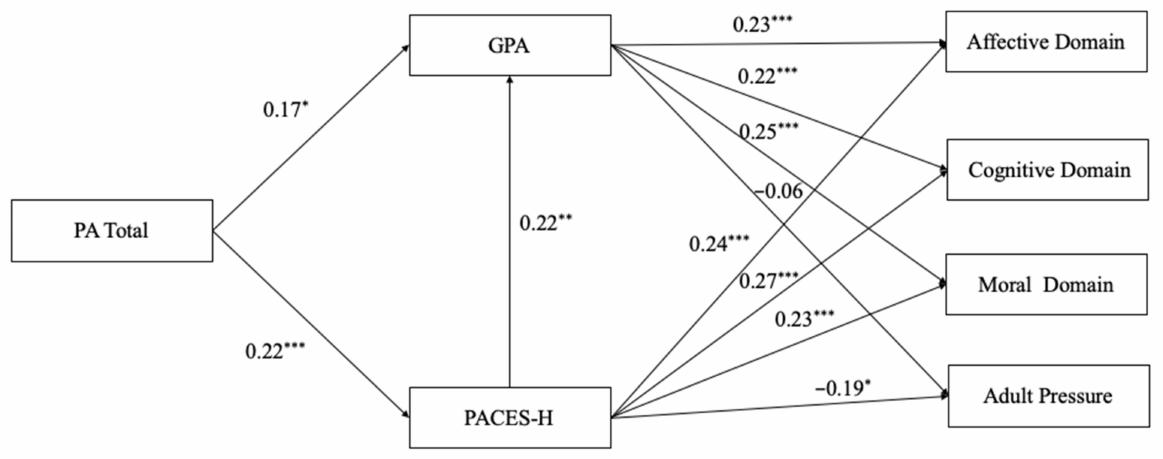
Figure 2. Results of path analysis between learning motivation, PACES-H, GPA, and PA total. Note. * p < 0.05; ** p < 0.01; *** p <